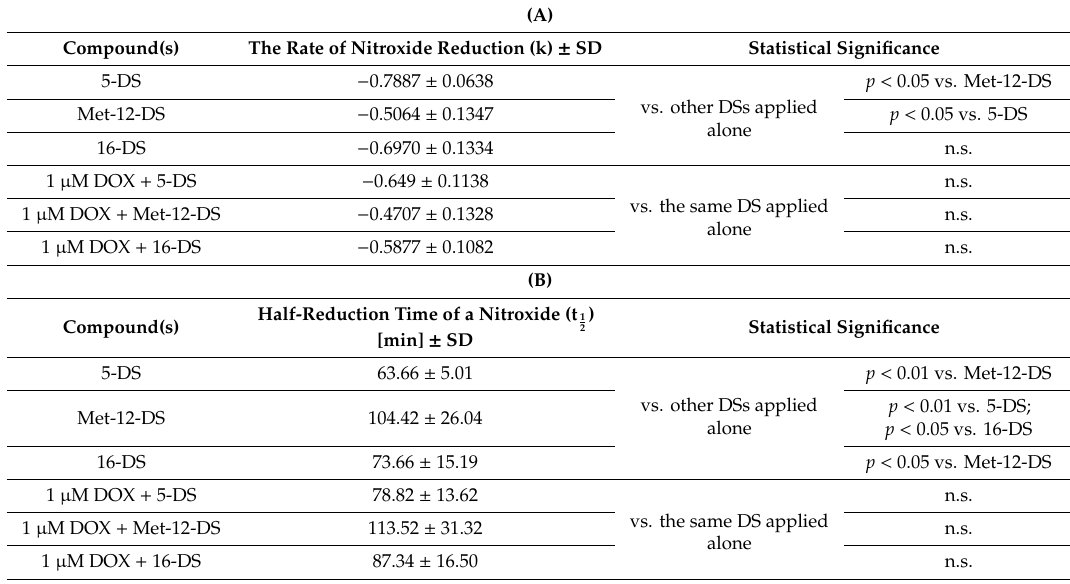
Table 1. ( A ) The rates of reduction (k) in B14 cells of the doxyl stearate nitroxides (5-DS, Met-12-DS, and 16-DS) applied alone at the final concentration of 80 µ M or together with 1 µ M doxorubicin (DOX). The data are presented as means ± SD of at least three independent experiments. ( B ) Half-reduction times in B14 cells of the doxyl stearate nitroxides (5-DS, Met-12-DS, and 16-DS) applied alone at the final concentration of 80 µ M or together with 1 µ M doxorubicin (DOX). The data are presented as means ± SD of at least three independent